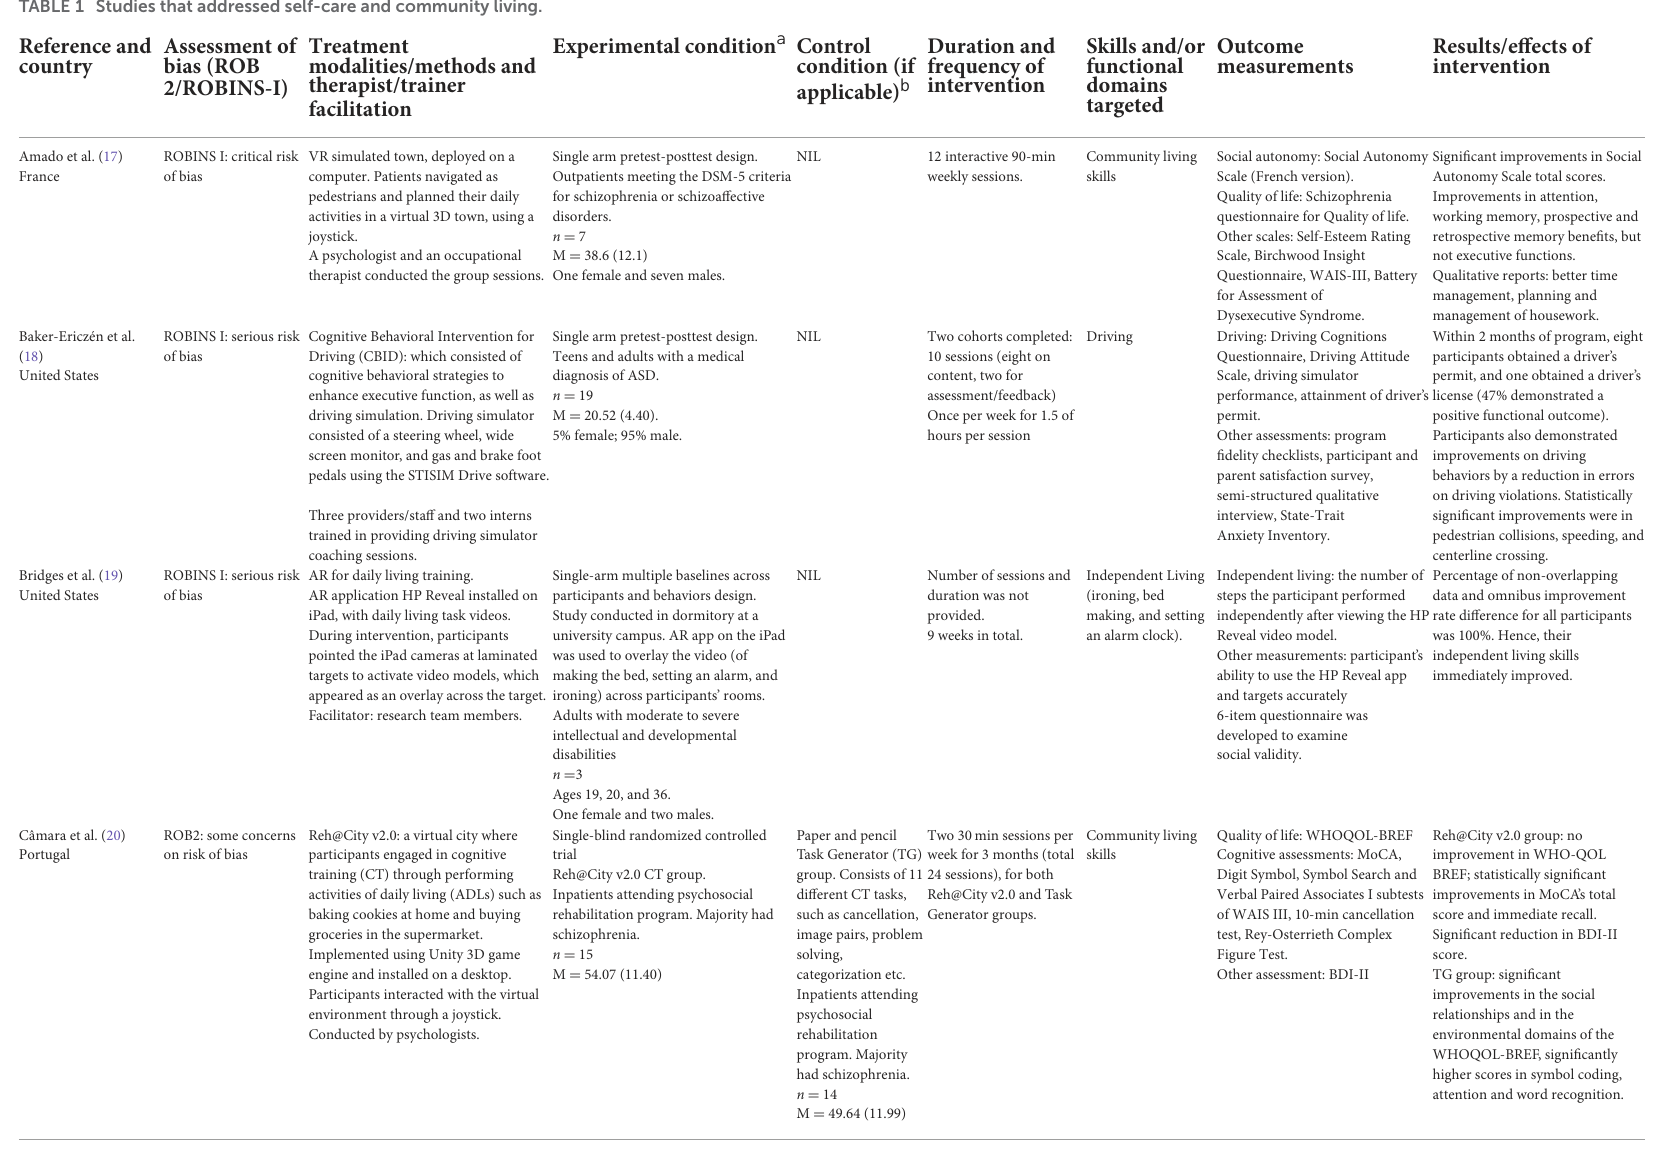
TABLE 1 Studies that addressed self-care and community